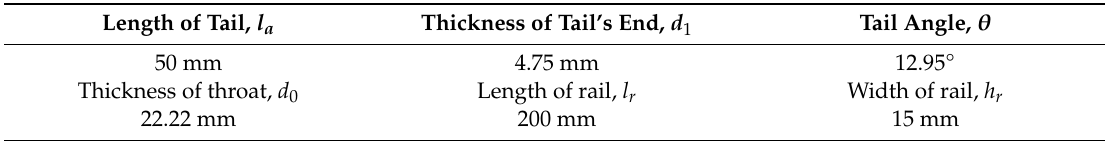
Table 1. Structural parameters of armature and rail.